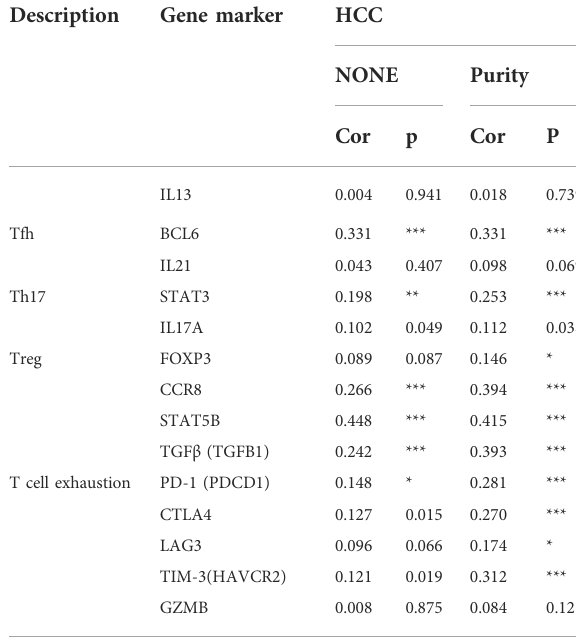
TABLE 2 ( Continued ) Correlation analysis between PIGC and relate genes and markers of immune cells in TIMER.